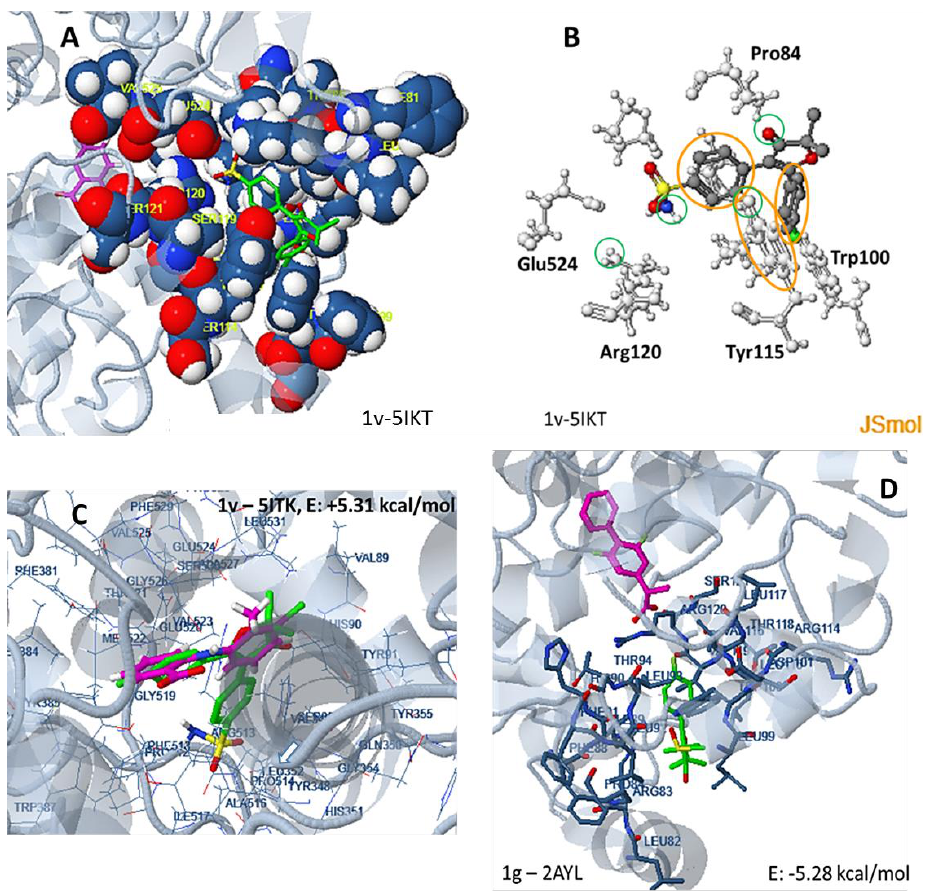
Figure 3. Docking of compound 1v to the human COX-2 structure 5IKT, at a lower energy complex ( A , B ) with the compound docked at the entrance of the active site and at a high energy complex with the compound oriented in a deeper space of the active site ( C ). Docking of compound 1g to the ovine COX-1 structure 2AYL ( D ). Studied compound in green, initial ligand in magenta. Yellow cycles: pi–pi interactions, green cycles: polar interactions. Polar interactions are also formed between Arg120 and the –SO 2 NH 2 group.